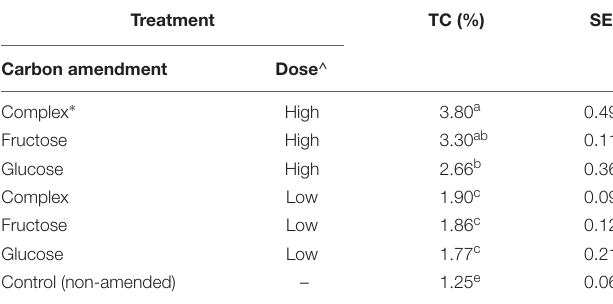
TABLE 1 | Mean total carbon (TC) content in carbon-amended and non-amended soils.